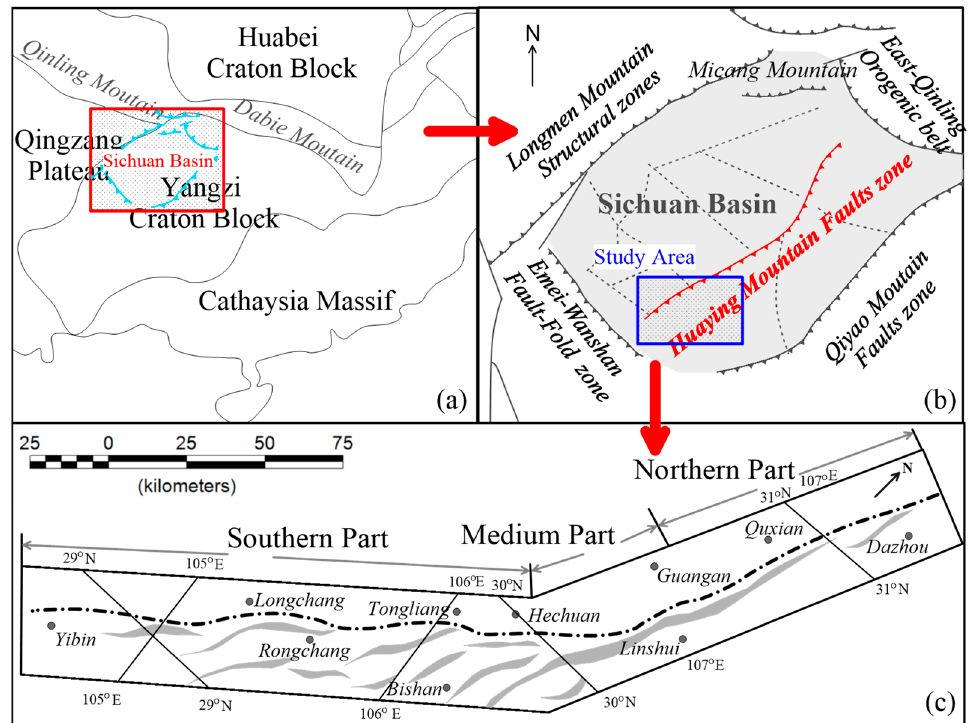
Figure 1. Location Map of Huaying Mountain Faults Zone. ( a ) is the tectonic outline map of Yangtze craton (The revision from Li et al., 2019 [7]), the red rectangle is the range of ( b ), the blue line is the scope of the Sichuan Basin; ( b ) is the tectonic outline map of Sichuan Basin (revision from He et al., 2011), the blue rectangle is the study area in this paper; ( c ) is the distribution of the Huaying Mountain fault, which is shown in red line in ( b ) (revision from Wang et al., 2018 [8]). HMFZ is a typical fault zone containing many great scale and depth faults that have meaningfully driven the tectonic evolution of southeast Sichuan meaningfully. Thus, HMFZ has been critical to the research on tectonic evolution and distribution of oil and gas reservoirs in this region [9 – 11]. Moreover, the development of an ejective fold in eastern Sichuan has been linked to many tectonic events (e.g., the Caledonian-Hercynian and Indosinian cycles) and many faults, including basement and thrust faults, were